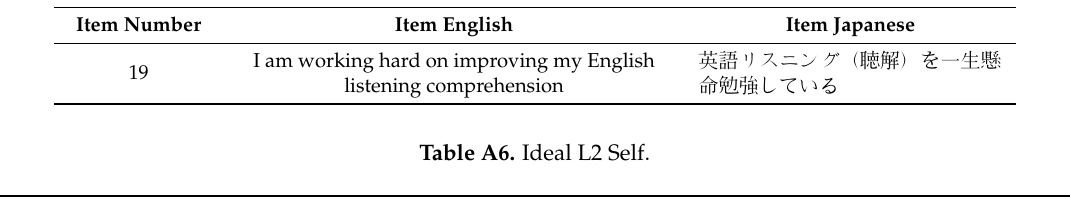
Table A5. Intended Study Effort.